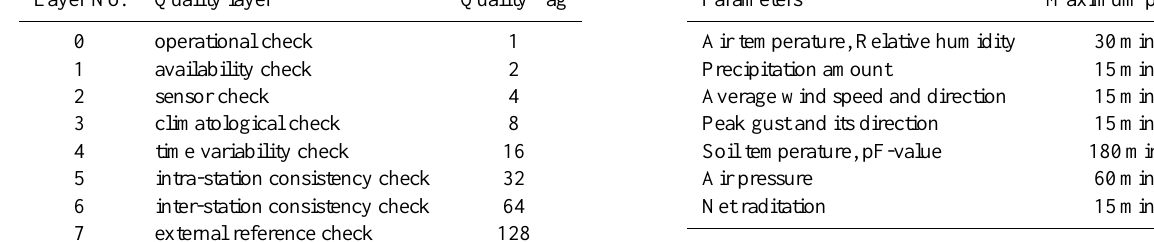
Table 2. Quality layers of the Quality Control System. Layer No.